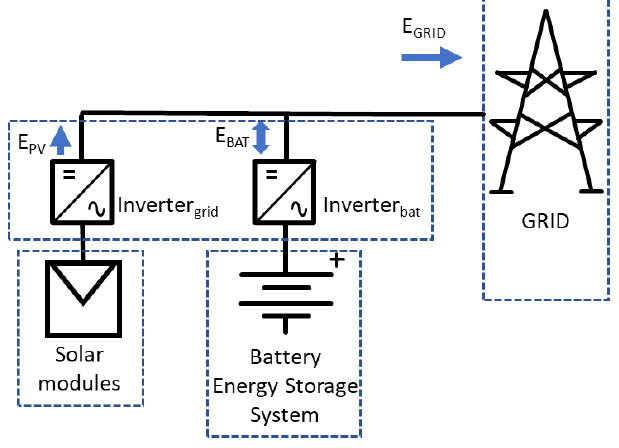
Figure 2. PV-BESS system.